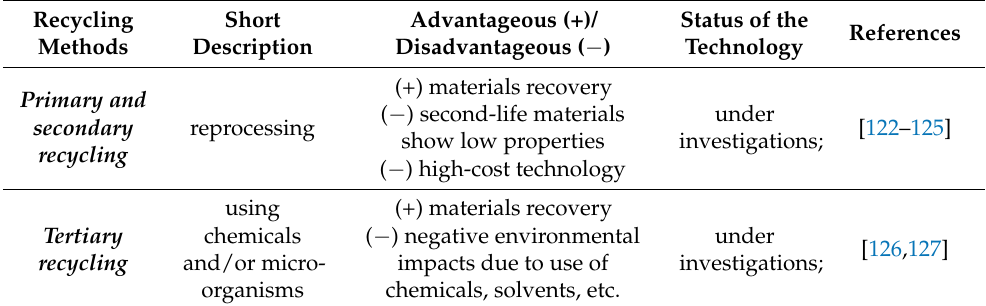
Table 4. Overview of recycling methods for bioplastics and bioplastic-based